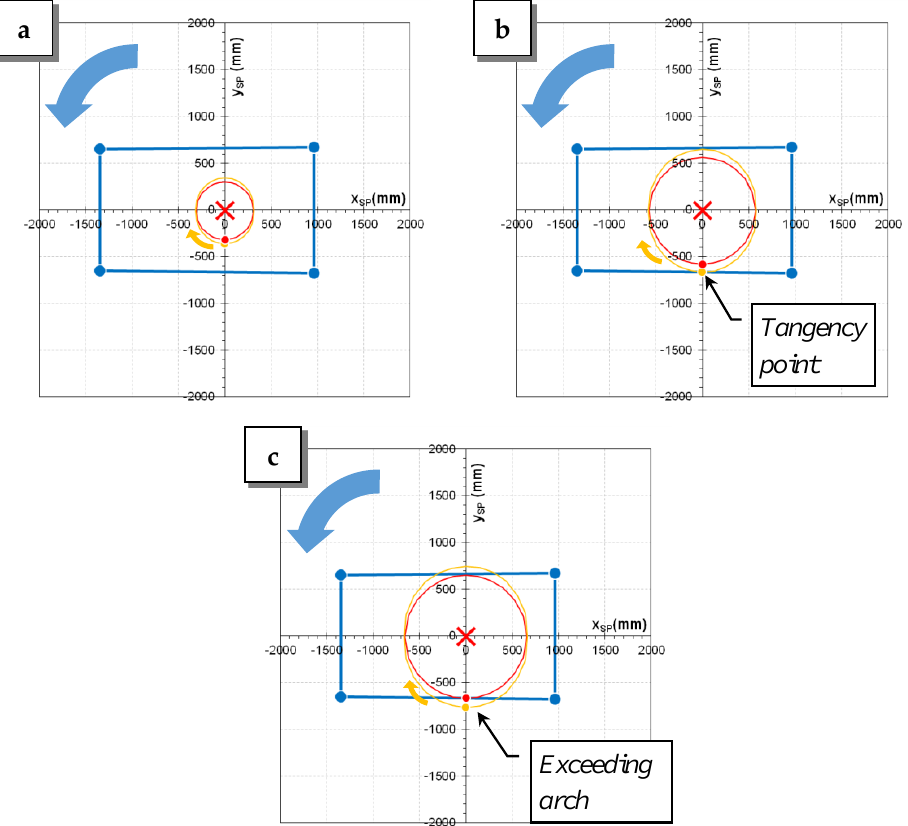
Figure 20. Locus of the positions of CoG′ in the frame of reference fixed to the turntable, when the turntable does a complete counter-clockwise rotation around its rotation axis (i.e., the origin of the reference frame) for ( a ) α = 20.00°, ( b ) α = 33.95° and ( c ) α = 37.73°. The blue arrow indicates the direction of rotation of the support platform (the y SP axis is oriented as in the figures only at the beginning, then rotates accordingly to the blue arrow); the orange arrow instead indicates the direction of travel of the locus of the positions of CoG′ (the initial point is the one evidenced, then it moves clockwise along the orange circumference). It is reported for proper comparisons also the locus of the positions of CoG′ in case of non-deformable tyres. The red cross indicates the position of CoG″ (NB: not coincident with the origin).